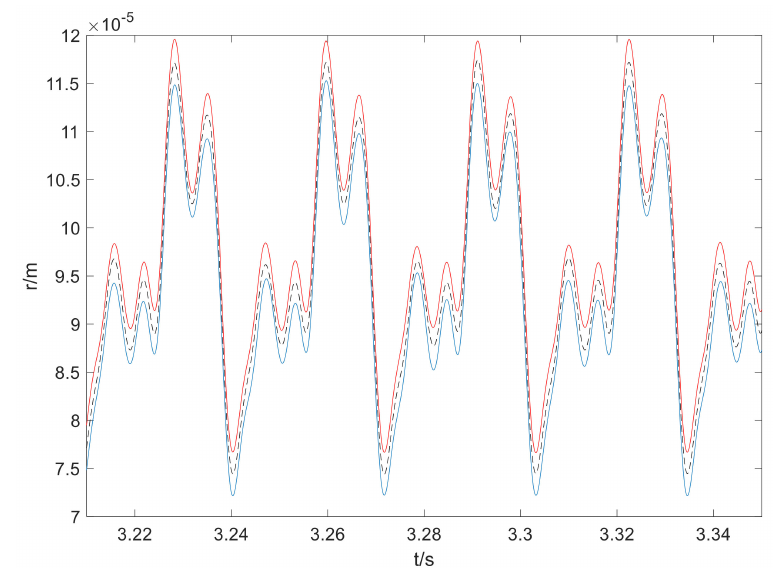
Figure 6. Vibrations of the rubbing rotor with 5% bounded clearance uncertainty: blue solid line = lower bound; red solid line = upper bound; black dotted line = deterministic curve.